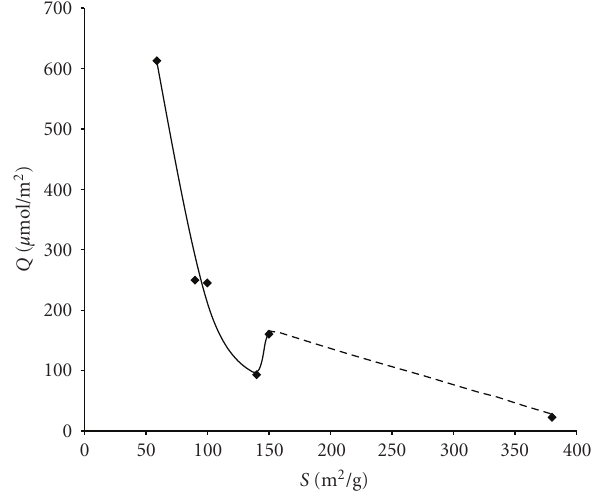
Figure 2: Overall content of adsorption centers on the surface of the studied samples as a function of their specific surface area.